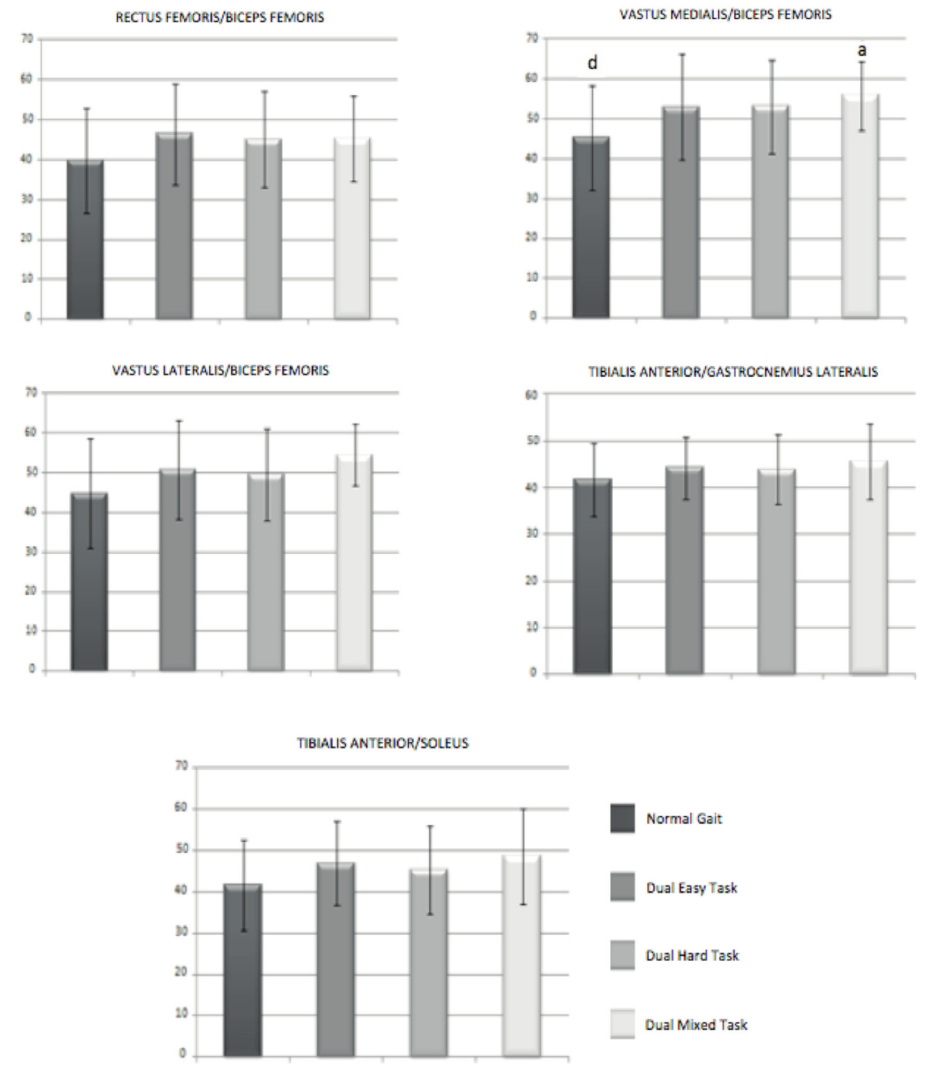
Figure 2 - Means and standard deviations for co-contraction percentage in different test phases between rectus femoris/ biceps femoris, vastus medialis/ biceps femoris, vastus lateralis/ biceps femoris, tibialis anterior/ gastrocnemius lateralis, and tibialis anterior/ soleus